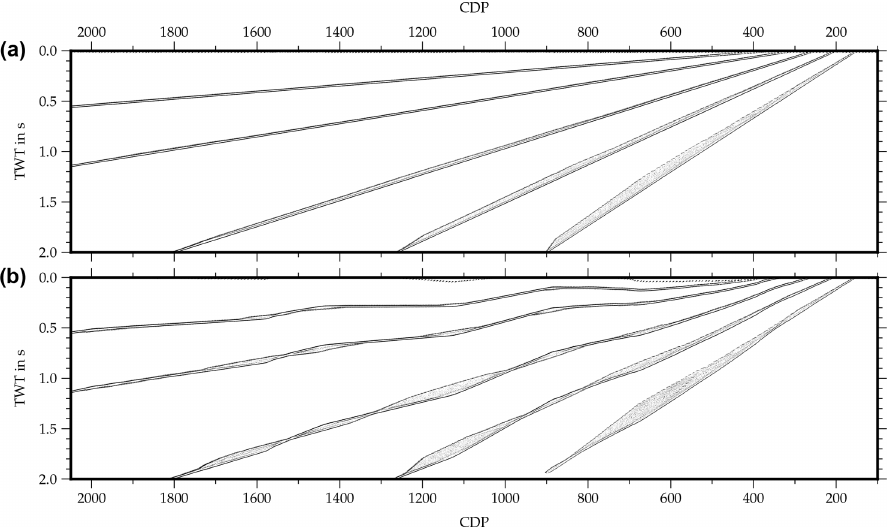
Figure 7. Results of the second synthetic model with reflectors dipping in the inline direction. Panel (a) shows a stack without cross-dip correction that exhibits the normal smearing due to inline dip. Panel (b) shows a stack with a constant cross-dip correction of − 10 ◦ applied. The reflections get clearly distorted due to the falsely applied cross-dip correction. In most areas, smearing is increased but locally, reflections focus